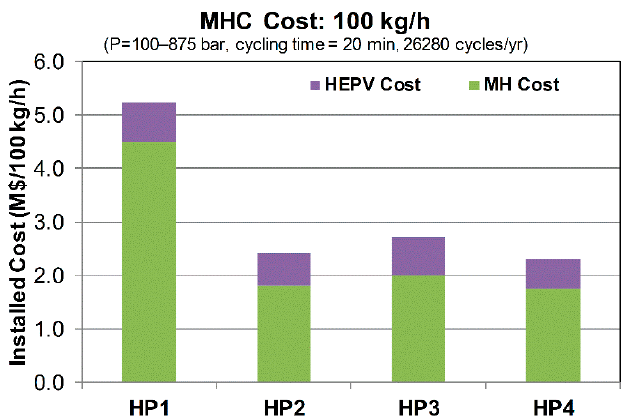
Figure 3. Installed cost of the MHC system for small-scale scenarios (i.e., 1 kg H2 /h).